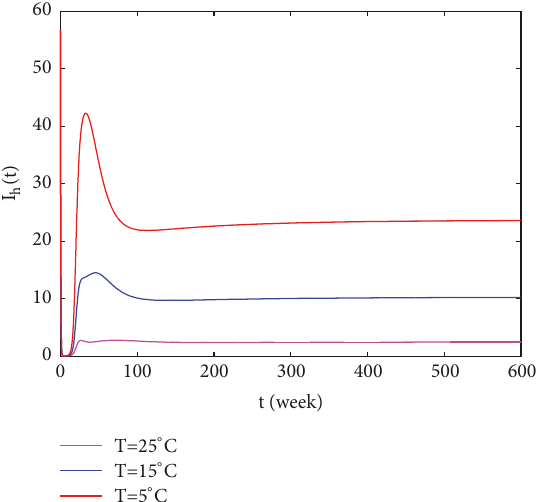
Figure 4: The curve-trend diagram of 𝐼 ℎ with time, when 𝑇 takes different values.